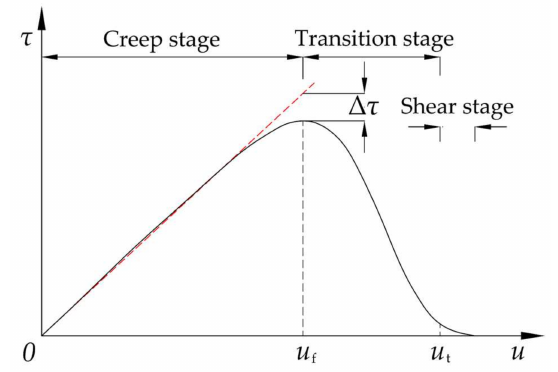
Figure 5. Constitutive model curve for sliding zone